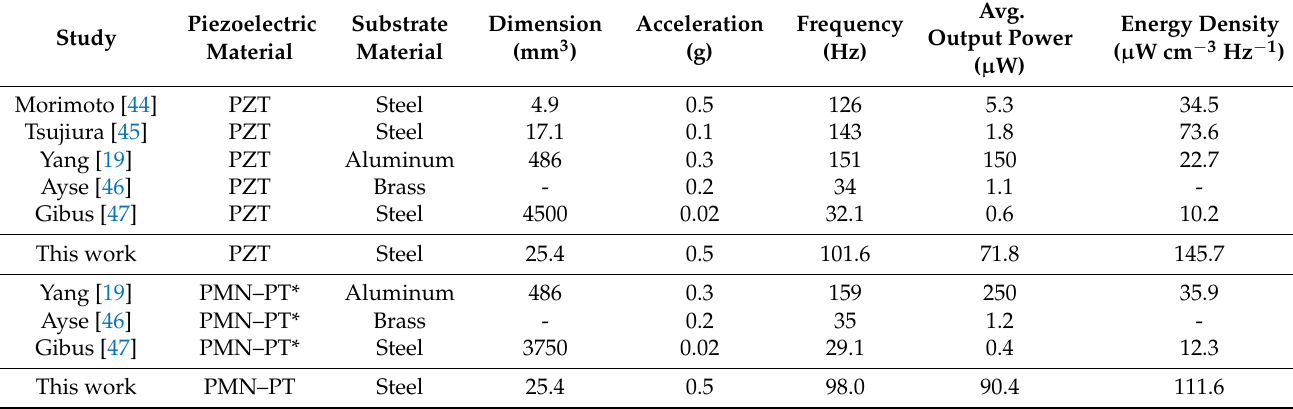
Table 5. Previously reported PZT- and PMN–PT-based energy harvesters with a metal substrate.